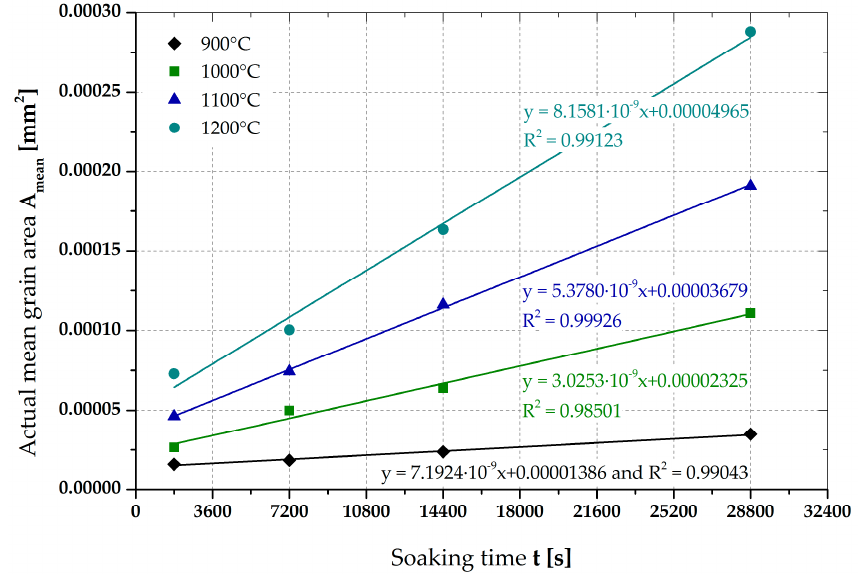
Figure 3. Actual mean grain area for S700MC steel vs. soaking time at temperatures of 900 ◦ C, 1000 ◦ C, 1100 ◦ C, and 1200 ◦ C (according to ISO 643).